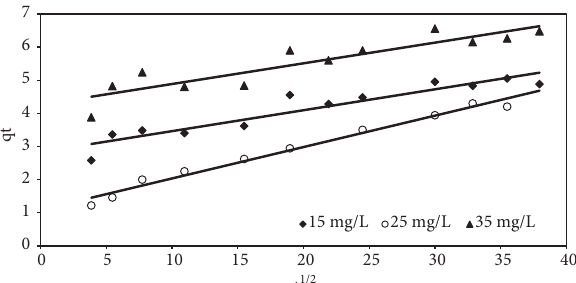
Fig. 9. Intraparticle diffusion for the adsorption of Cu 2+ onto the eggshell at various adsorbate amounts